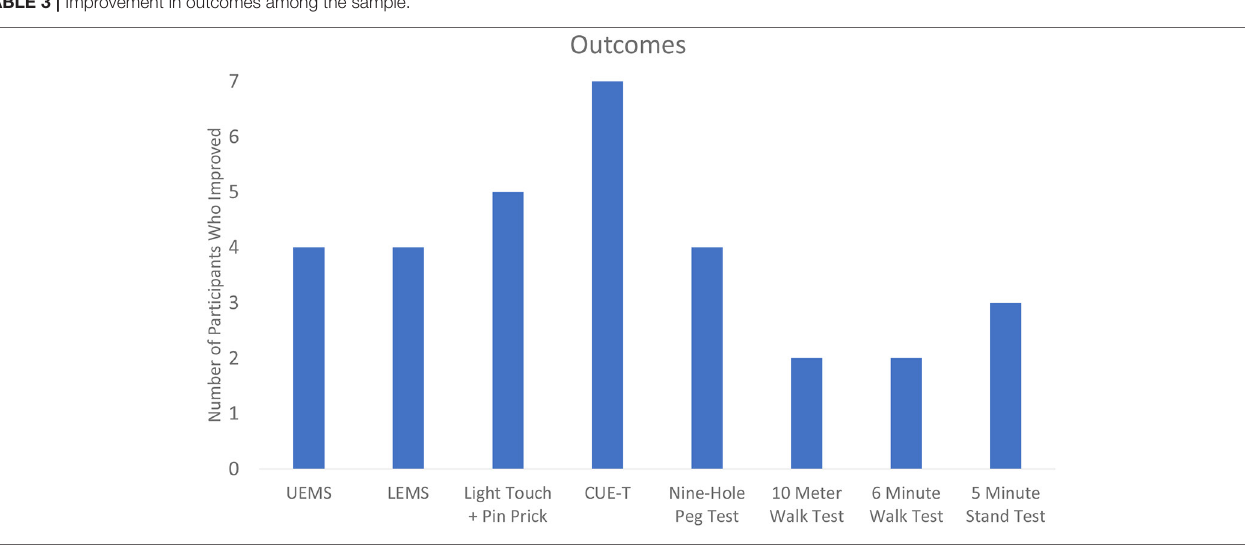
TABLE 3 | Improvement in outcomes among the